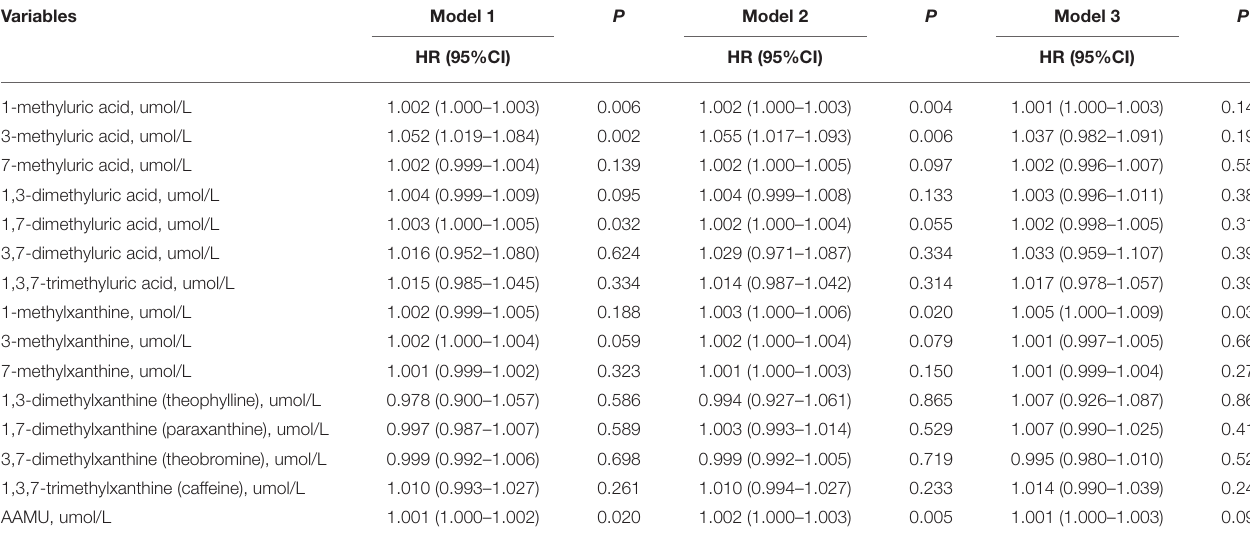
TABLE 3 | The association of urinary caffeine metabolites and the risk of the all-cause death in CVD population.